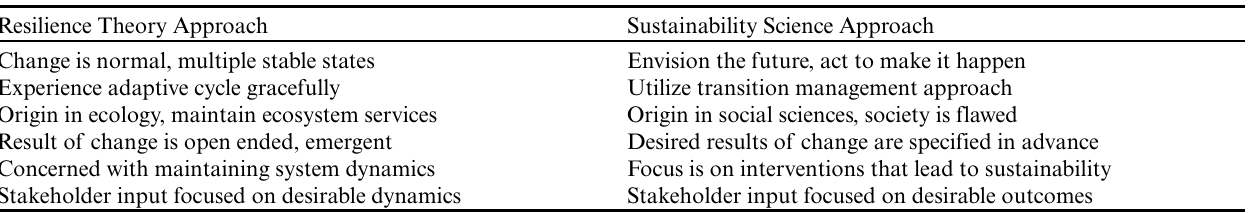
Table 2 . Contrasting elements of resilience and